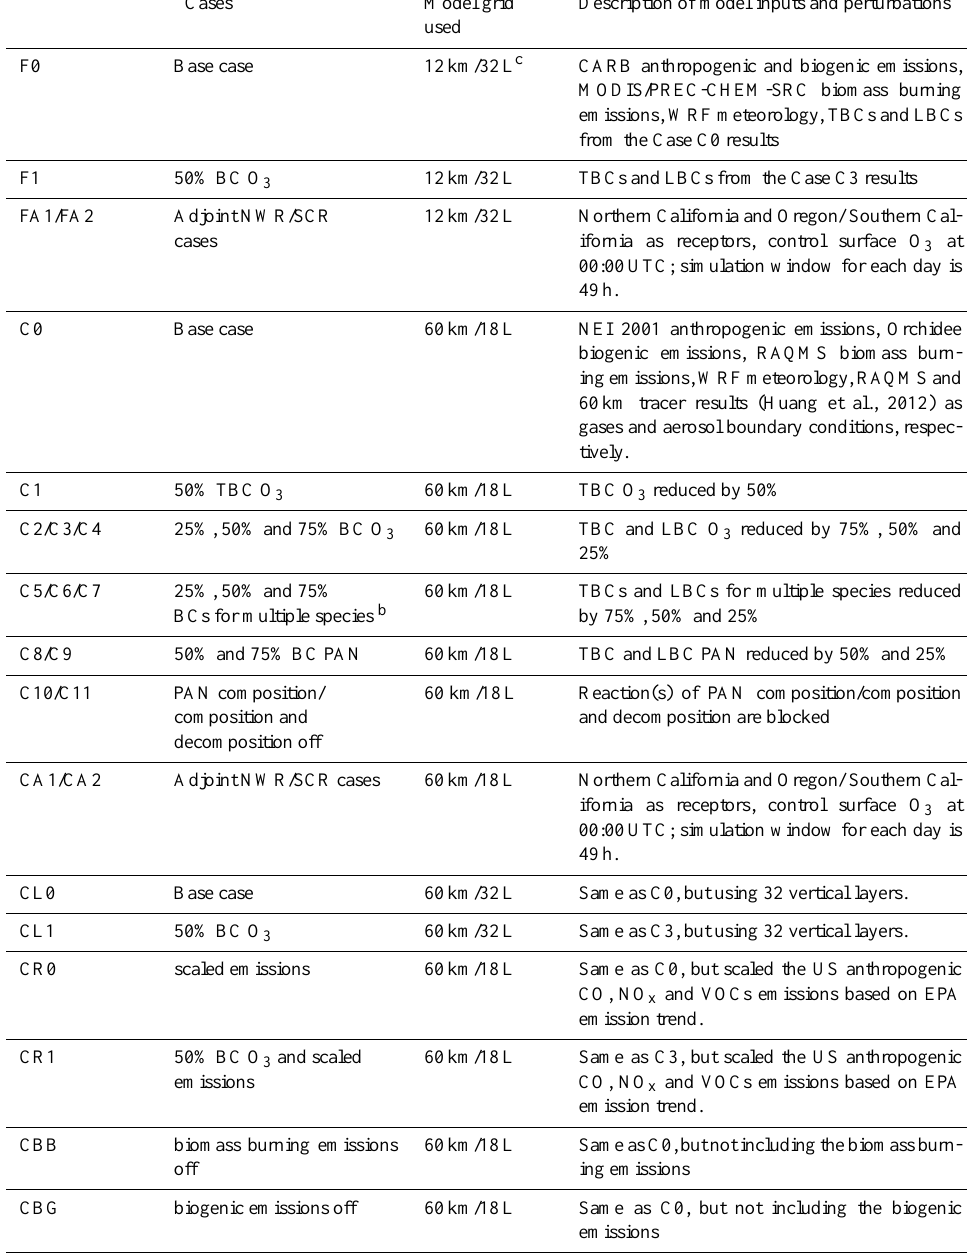
Table 2. Description of STEM base and sensitivity (forward and adjoint) simulations a